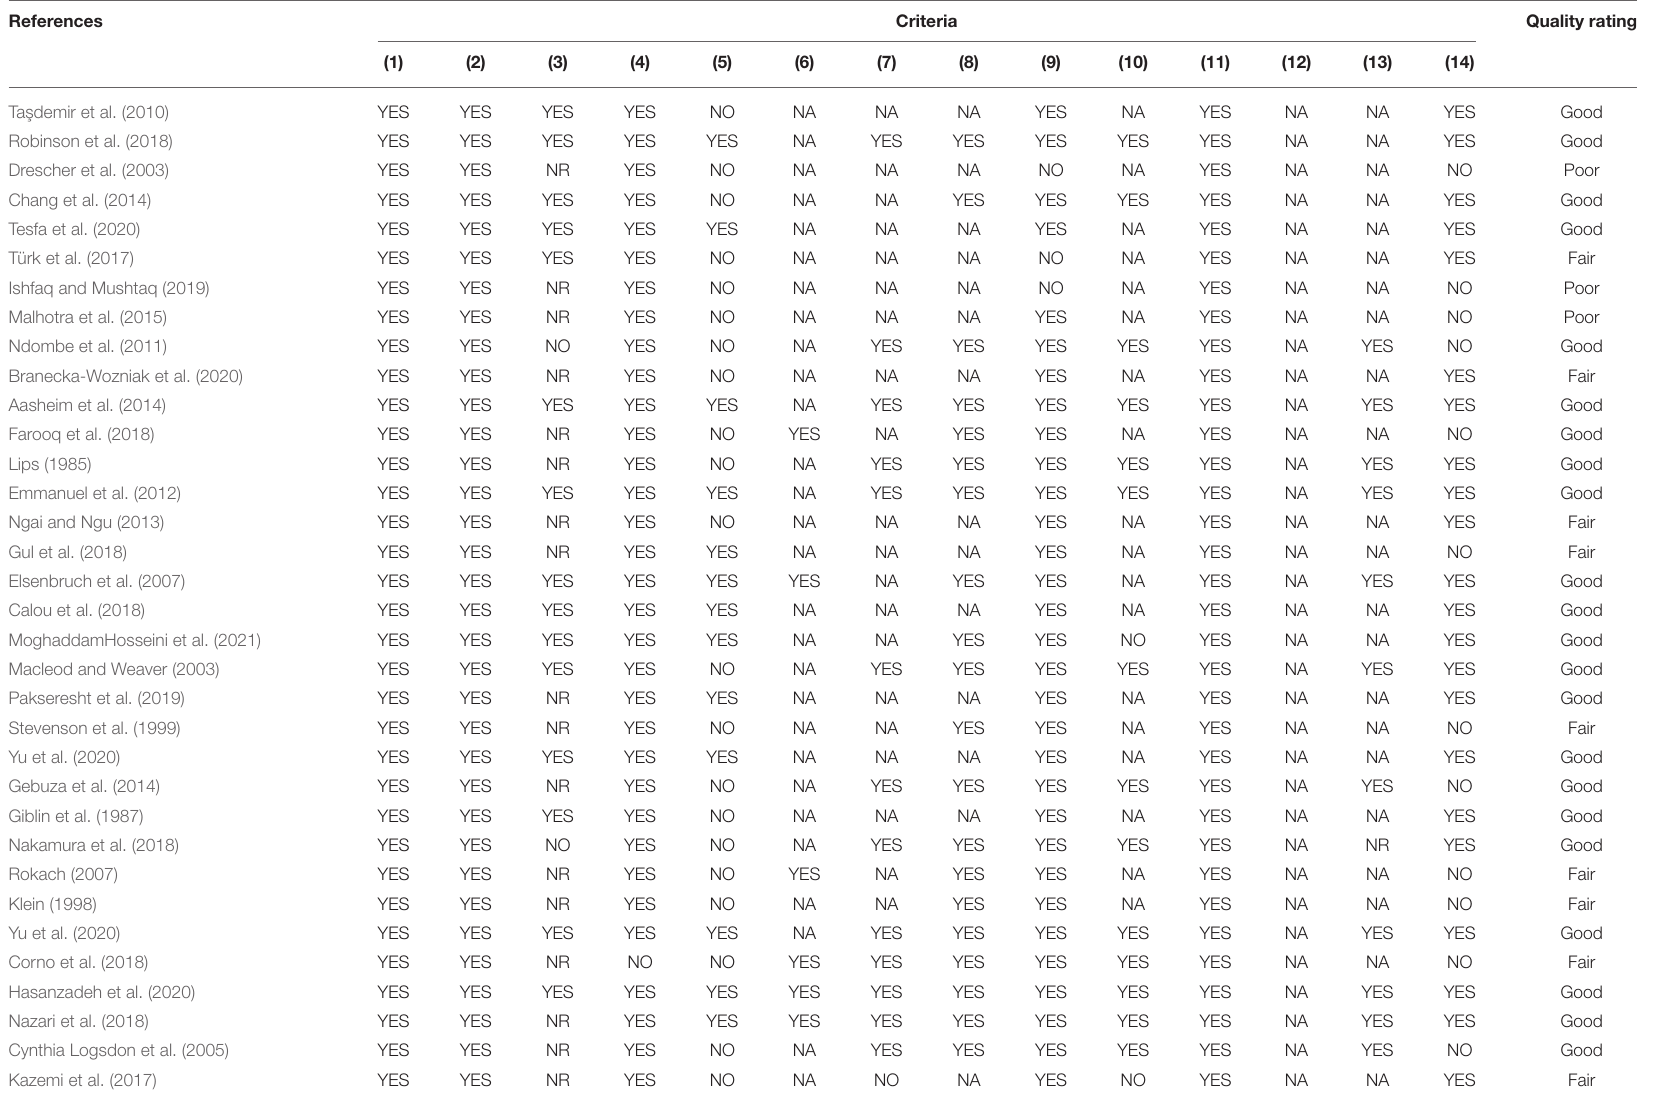
TABLE 4 | Summary of risk